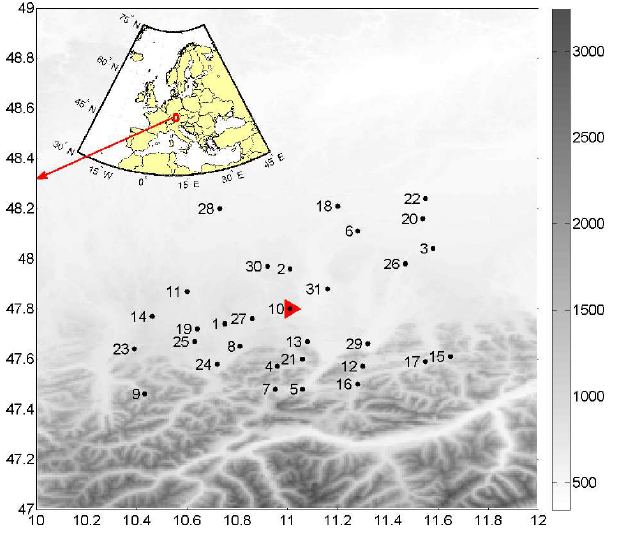
Fig. 1: Research area showing the position of the gauges and Fig. 1. Research area showing the position of the gauges and the weather radar on Mount Hohenpeissenberg (red triangle). The the weather radar on Mount Hohenpeissenberg (red triangle). names of the gauge stations (black dots) can be found in Table 1.